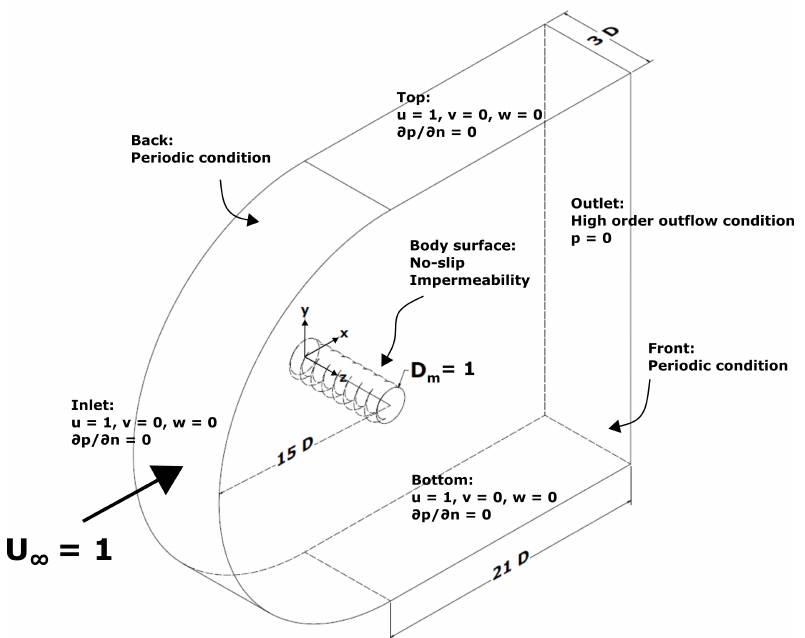
Figure 6. Computational domain (representative, not to scale) showing the surfaces on which boundary conditions are applied.